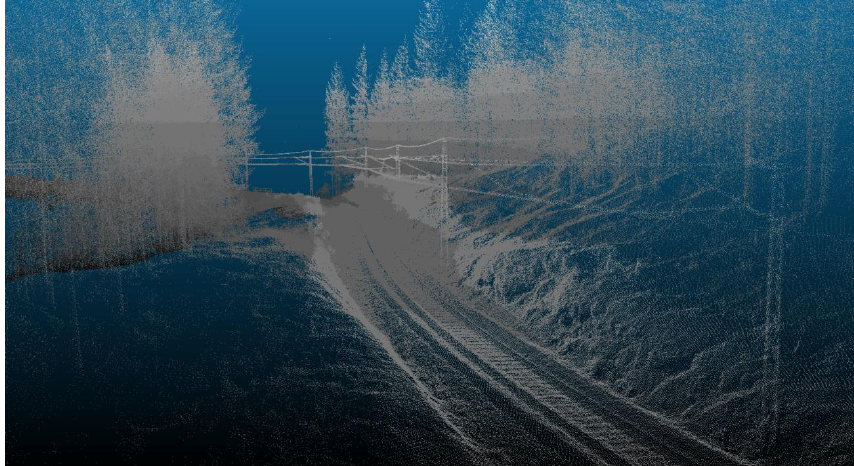
Figure 14. A close-up view of Austrian railroad